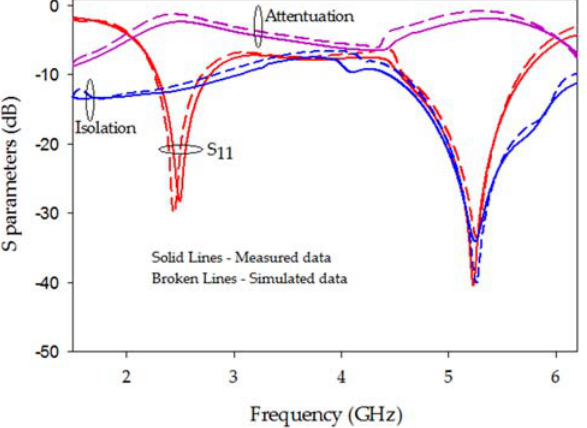
Figure 5. Variation of S parameters with frequency for a Square Patch Crossover.